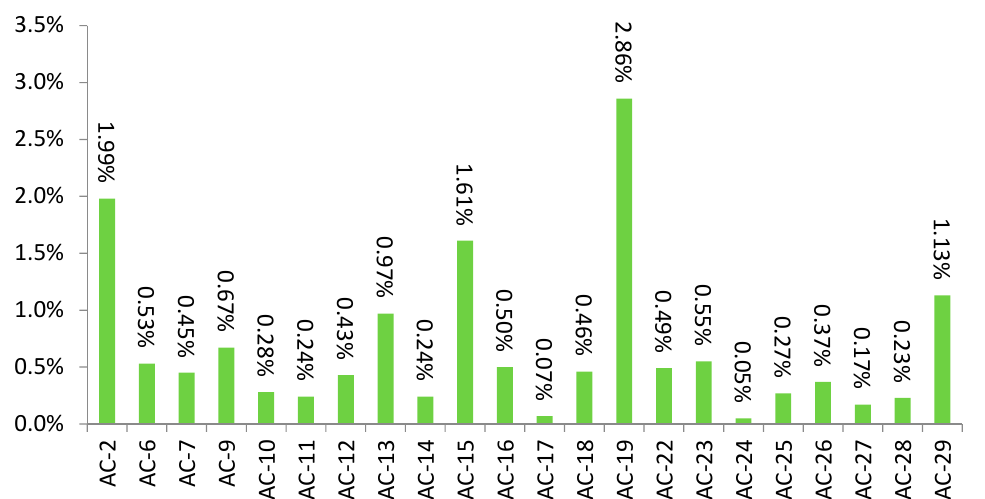
Figure 1. Percentages of ANA patterns with total occurrence frequency (in all tested samples) of less than 3%, determined using indirect immunofluorescence assay on HEp-2 cells in 1:100 dilution.